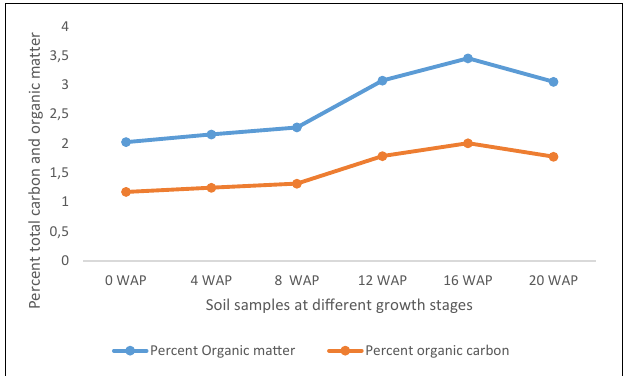
FIGURE 6 | Carbon and organic matter content of soil samples from 0 WAP to harvest (20 WAP).